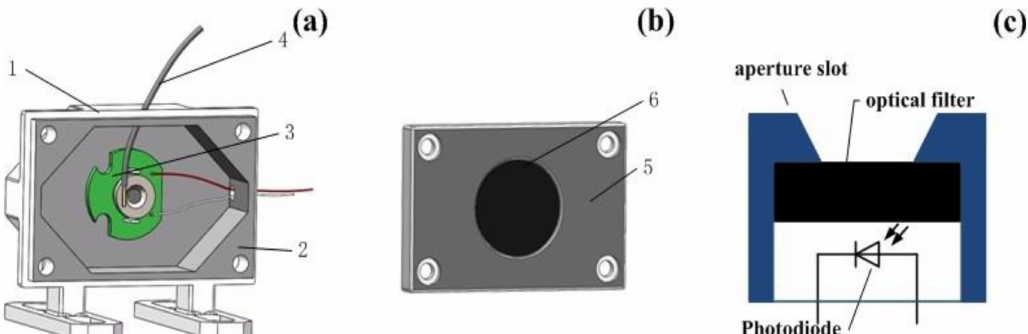
Figure 9. ( a ) The structure of the shielding box ( b ) The shielding cover ( c ) The structure of the UV radiometer (XINBAO U340B) with the OSRAM’s BPW66C photodiode, UVA + UVB detecting range, 2.5 times/second sampling rate and ± (4%FS + 2DGT)